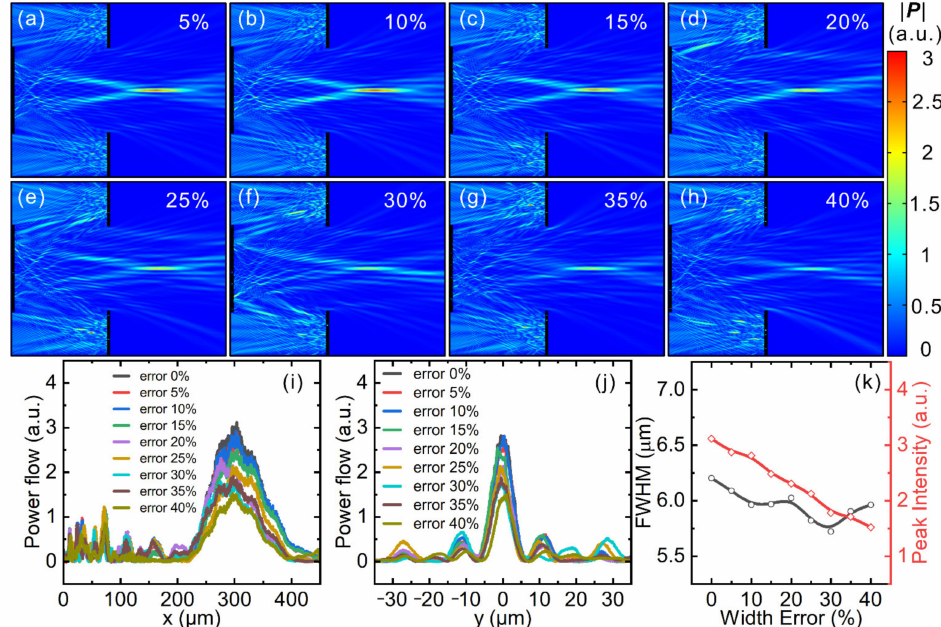
Figure A3. Energy flux of a metasurface Cassegrain telescope with f-ratio of 5/6 with ( a ) 5%, ( b ) 10%, ( c ) 15%, ( d ) 20%, ( e ) 25%, ( f ) 30%, ( g ) 35% and ( h ) 40% random width error applied to the meta-atoms. Also shown are line-cut plots of the focus along ( i ) x- and ( j ) y-directions, as well as ( k ) FWHM (black-curve) and peak intensity (red-curve) of the focus for different devices with various level of random width error of